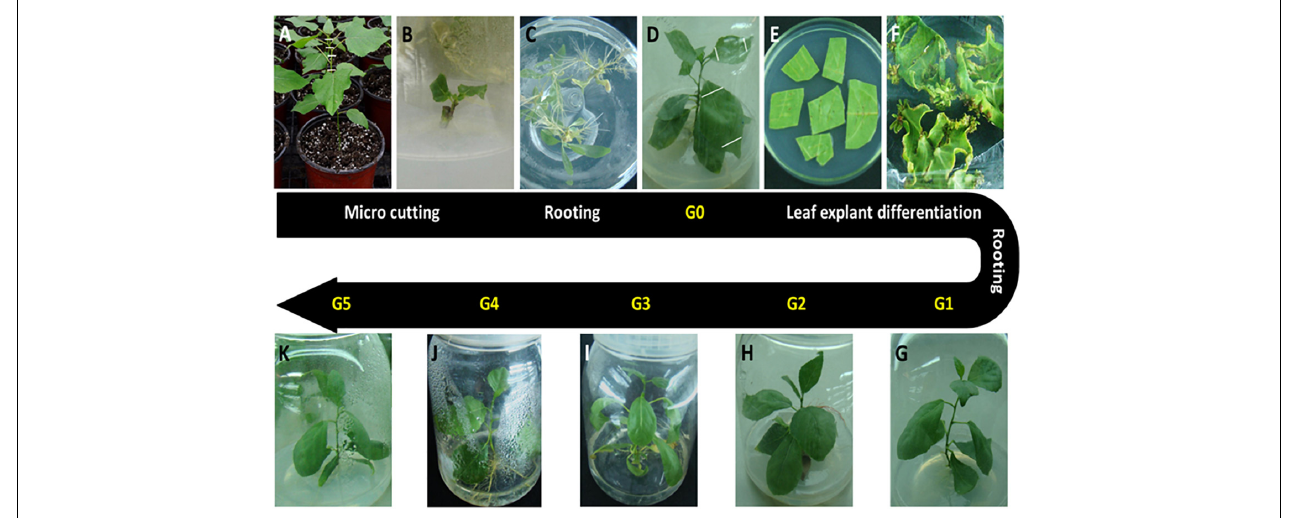
FIGURE 1 | Plant materials used in this study. All in vitro materials were derived from the Populus nigra clone “N46.” (A) Starting material. Stem cuttings (hash marks) were cut from plants grown in a greenhouse. (B) Stem cuttings were cultured on hormone-free Murashige and Skoog medium for 2–3 weeks until axillary buds matured. (C) Shoots were cultured on rooting medium for 4 weeks. (D) Plants were grown to 7–8 cm and designated as donor plants (G0). (E) Leaf discs were cut from G0 plants and cultured on shoot induction medium. (F) Adventitious shoots initiated| from calli formed on leaf cutting edges. (G) Adventitious shoots